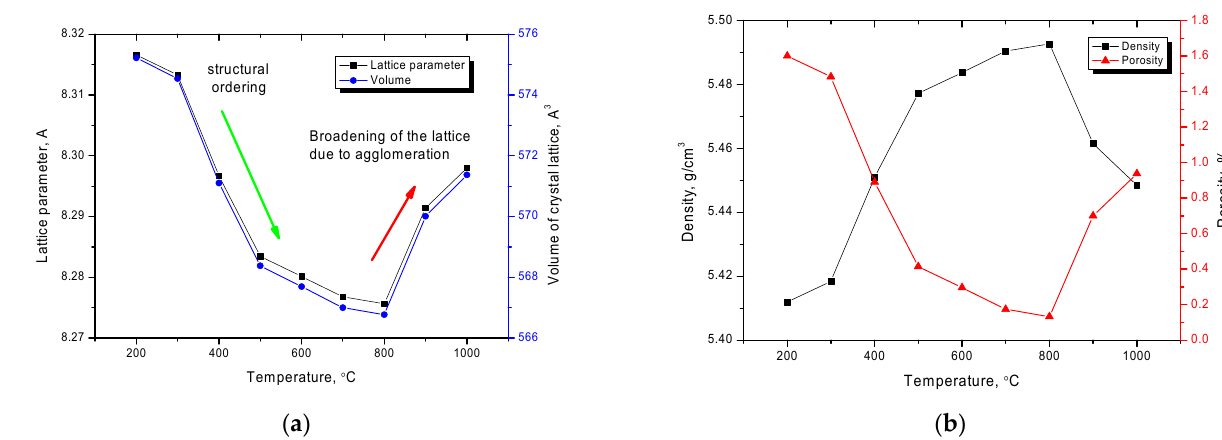
Figure 3. ( a ) Diagram of lattice structural parameters of NiFe 2 O 4 nanoparticles as a function of annealing temperature; ( b ) diagram of nanoparticle density and integral porosity.